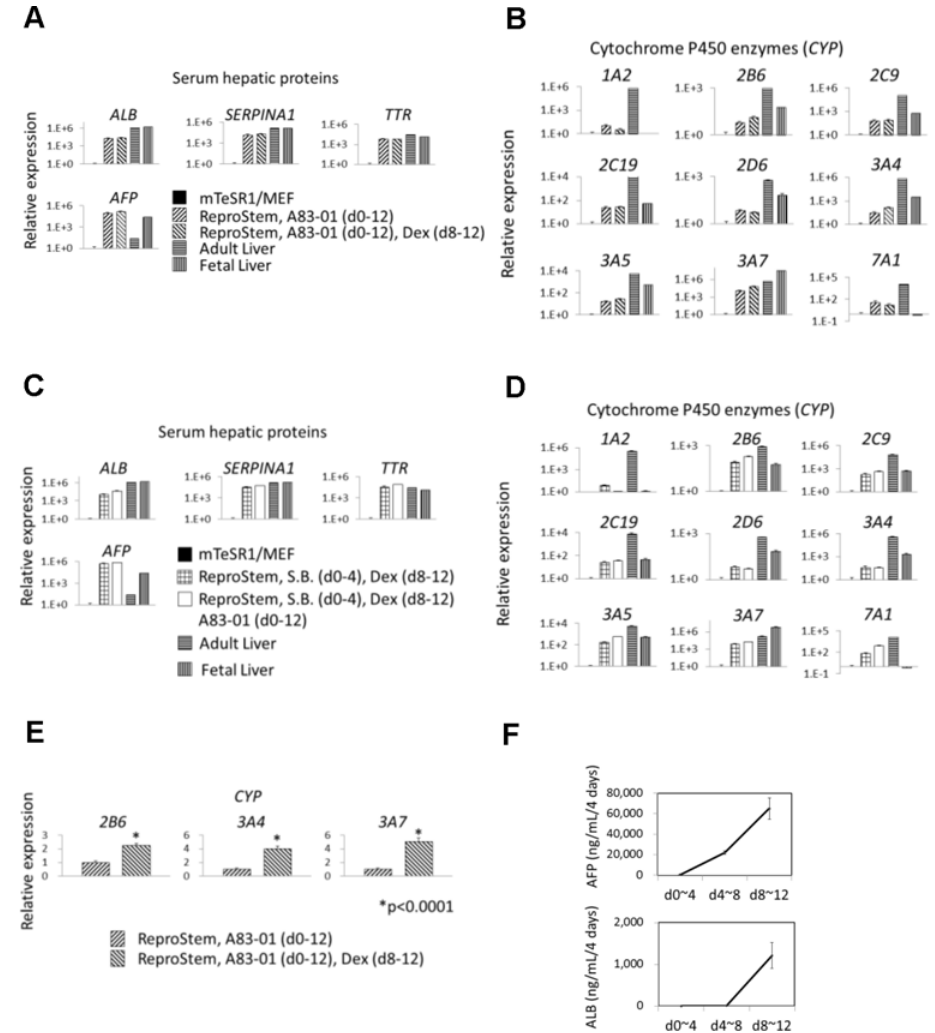
Fig 2. Hepatic differentiation of hiHSCs by depletion of FGF-2. Self-renewing hiHSCs, clones AFB1-1 and NGC1-1, differentiate into hepatocyte-like cells with the omission of FGF-2 from ReproStem medium. ( A – E ) Gene expression was analyzed by quantitative RT-PCR at day 12. Gene symbols are shown for serum hepatic proteins and cytochrome P450 enzymes. The terms of additions are indicated in parentheses. ( A – D ) Relative expression is shown with a logarithmic axis histogram. The expression is normalized to 1 in the self- renewing hiHSCs (mTeSR1/MEF) and compared to that of hepatocyte-like cells. Total RNAs of human fetal and adult livers were utilized as robust controls. Data are presented as mean+SEM and represent a minimum of three independent samples with at least two technical duplicates. ( A, B ) Clone AFB1-1 differentiated in the medium including an inhibitor (0.5 μ M A83-01) of TGF- β signaling or the medium including 0.5 μ M A83-01 plus 0.5 μ M dexamethasone (Dex). See also S11 and S12 Figs. ( C, D ) Clone NGC1-1 differentiated in the medium including 0.5 μ M sodium butyrate (S.B.) plus 0.5 μ M Dex or the medium including 0.5 μ M S.B. plus 0.5 μ M Dex plus 0.5 μ M A83-01. See also S13 and S14 Figs. ( E ) Clone AFB1-1 differentiated in the medium including 0.5 μ M A83-01 or the medium including 0.5 μ M A83-01 plus 0.5 μ M Dex. Relative expression is normalized to 1 in the medium without Dex and is shown in the histogram. The expressions of cytochrome P450 enzymes ( CYP2B6 , 3A4 , and 3A7 ) are induced by the addition of Dex. Asterisk indicates statistical significance as determined by t test. * p < 0.0001. ( F ) Release of human ALB and AFP was measured by ELISA on samples (supernatants of clone AFB1-1 differentiated with the medium including 0.5 μ M A83-01) at three time points. Data are presented as mean ± SEM and represent a minimum of three independent samples with at least two technical duplicates. See also Table